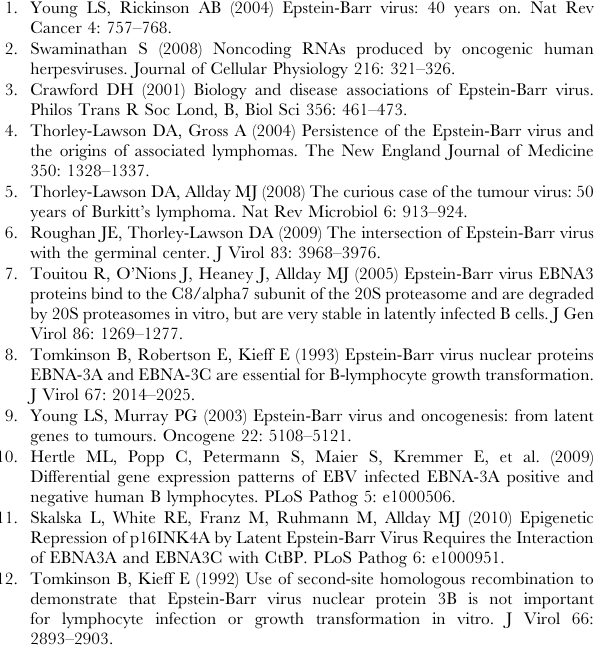
Table S10 Identities of qPCR assays used to test gene expression. All assays were used in Taqman low density array cards (Applied Biosystems). Top array set was used for assessing reliability of the microarrays (Figure 2 and S4). Lower list are additional assays used to assess reliability of transctipt-level microarray analysis (supporting information and Figure S5) Assay details (including map of where in the gene they map are available from the applied biosystems website. Table S11 Primers used for qPCR analysis of ChIP samples to determine histone modification association at cellular promoters. Position of the assay relative to transcription start site (-, upstream; + downstream) is indicated. Assay identifier (number -3 to + 2) is as used in Figures 5-8. ‘p’,